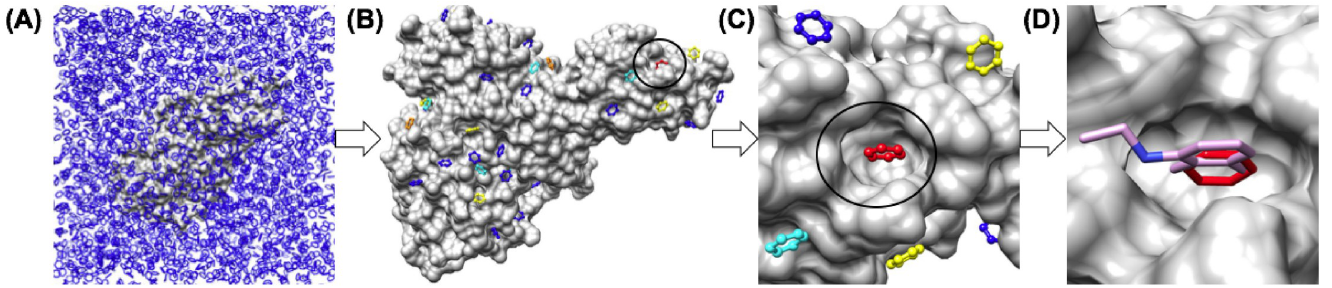
Fig 2. Overview of pharmacophore mapping and computational fragment screening. (A) Nsp13 helicase solvent mapping simulations with benzene solvent. (B) TOP50 sites are identified from analysis (hydrophobic contacts & geometric clustering). (C) CHARMM-based free energy calculations are utilized to calculate the free energy of the TOP50 sites and re-rank the list of aromatic pharmacophore sites by Δ G. Site 01 for the Nsp13 helicase is shown (red). (D) Fragment library screening is performed using the Site 01 aromatic pharmacophore a center-of-mass reference. Ligand efficiencies are then calculated from fragment screening data.